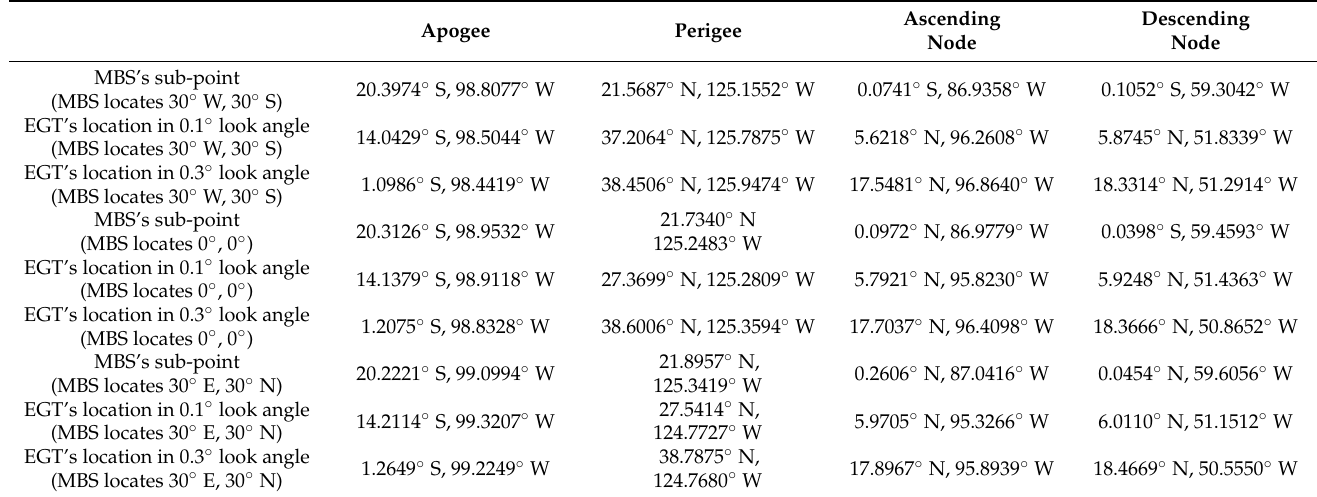
Table 1. The MBS’s sub-point and its bore-sight intersection on the Earth’s surface at one approximate apogee (i.e., 19:01:01 24 January 2001), one approximate perigee (i.e., 09:01:01 10 January 2001), one approximate ascending node (i.e., 11:01:01 15 January 2001), and one approximate descending node (i.e., 22:01:01 2 January 2001). The look angles here are all left-looking. Ascending Descending Apogee Perigee Node